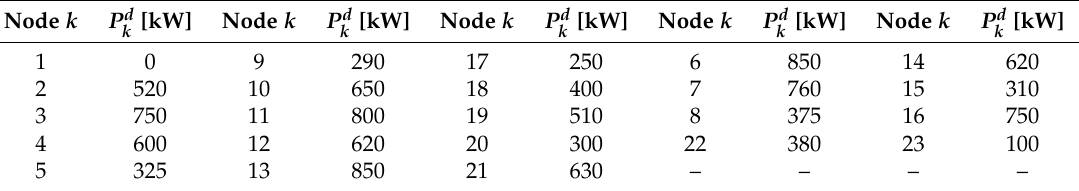
Table 4. Load information for the 23-nodes test